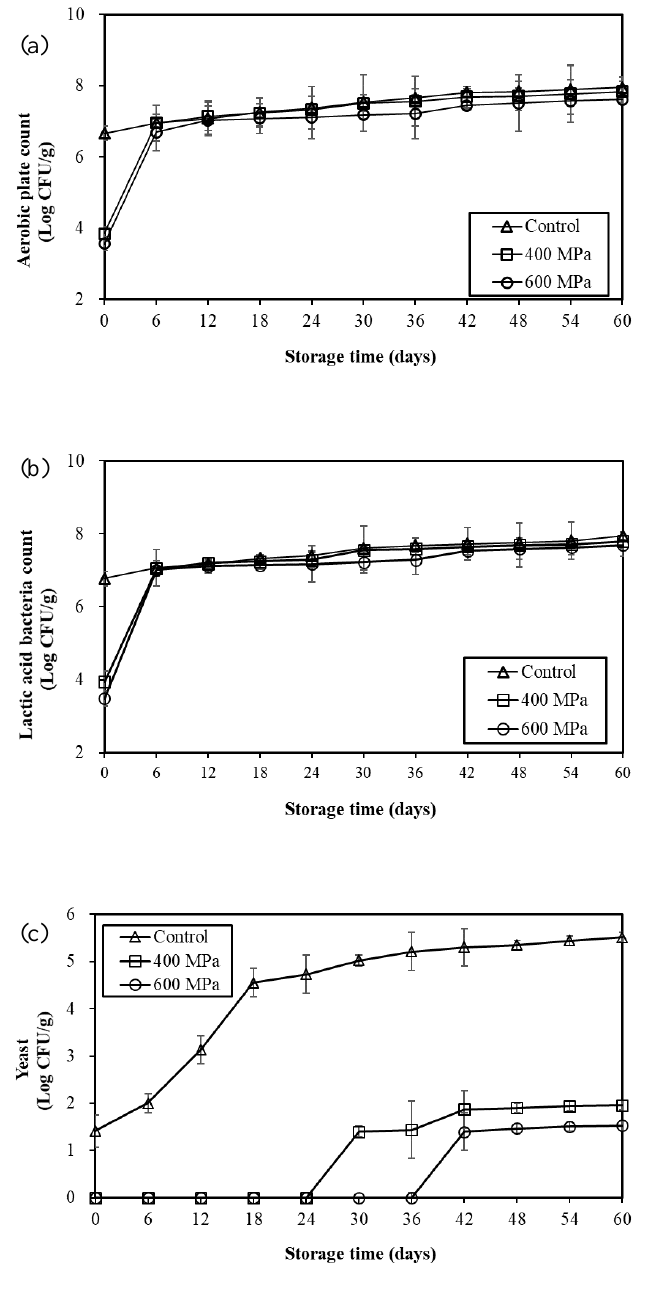
Figure 2. Changes of ( a ) aerobic plate count (APC), ( b ) lactic acid bacteria count, and ( c ) yeast in mustard pickles treated with HHP at 400 and 600 MPa for 5 min during storage at 25 °C.